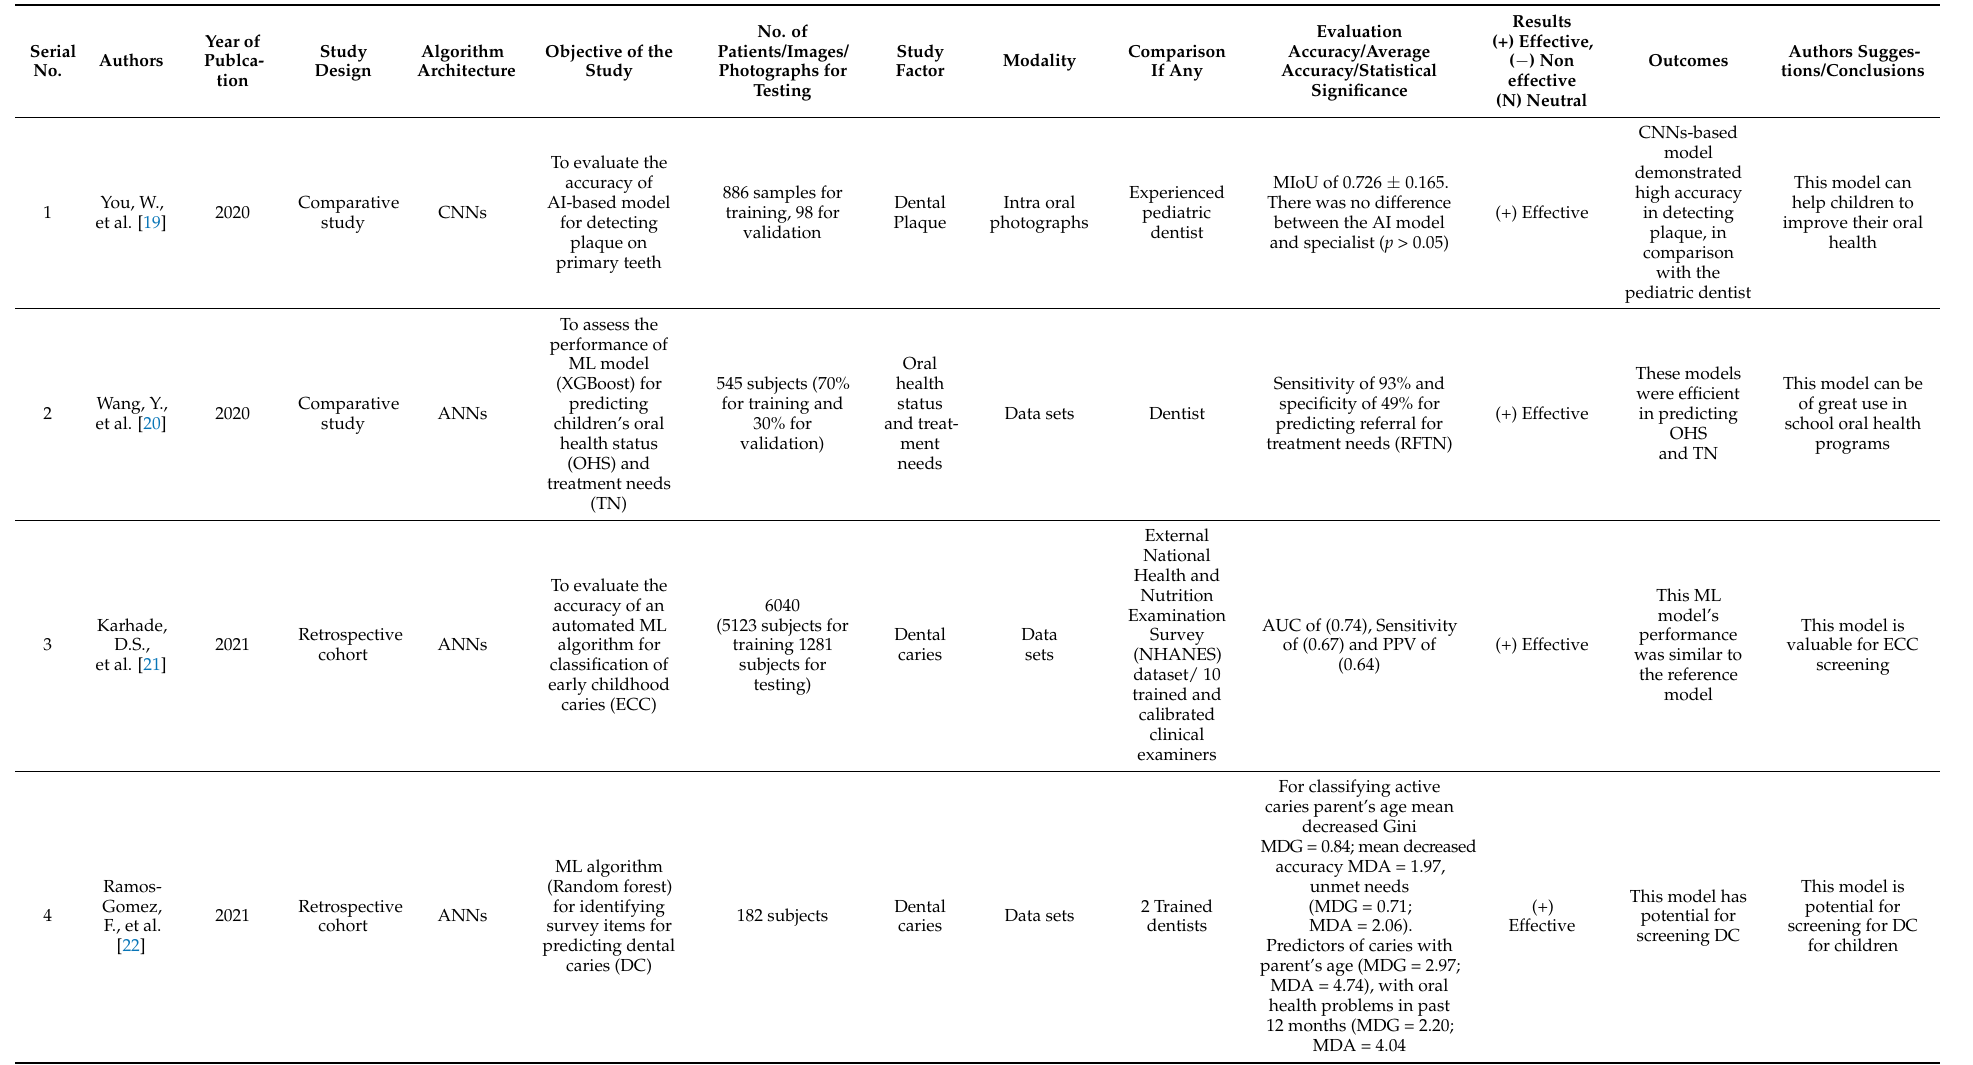
Table 2. Details of the studies that have used AI-based models in pediatric